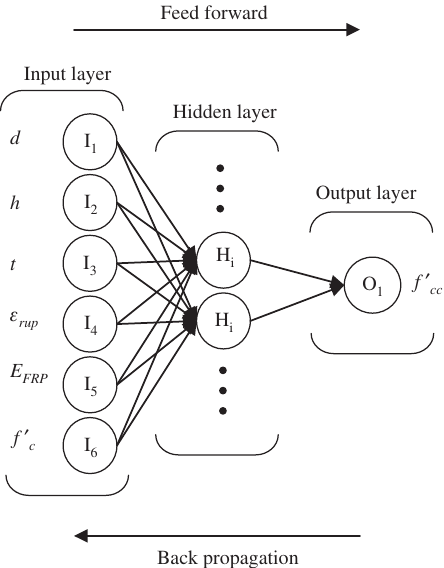
Figure 3 Schematic diagram of ANN model. selection. A GA allows a population composed of many individuals to evolve under specified selection rules to